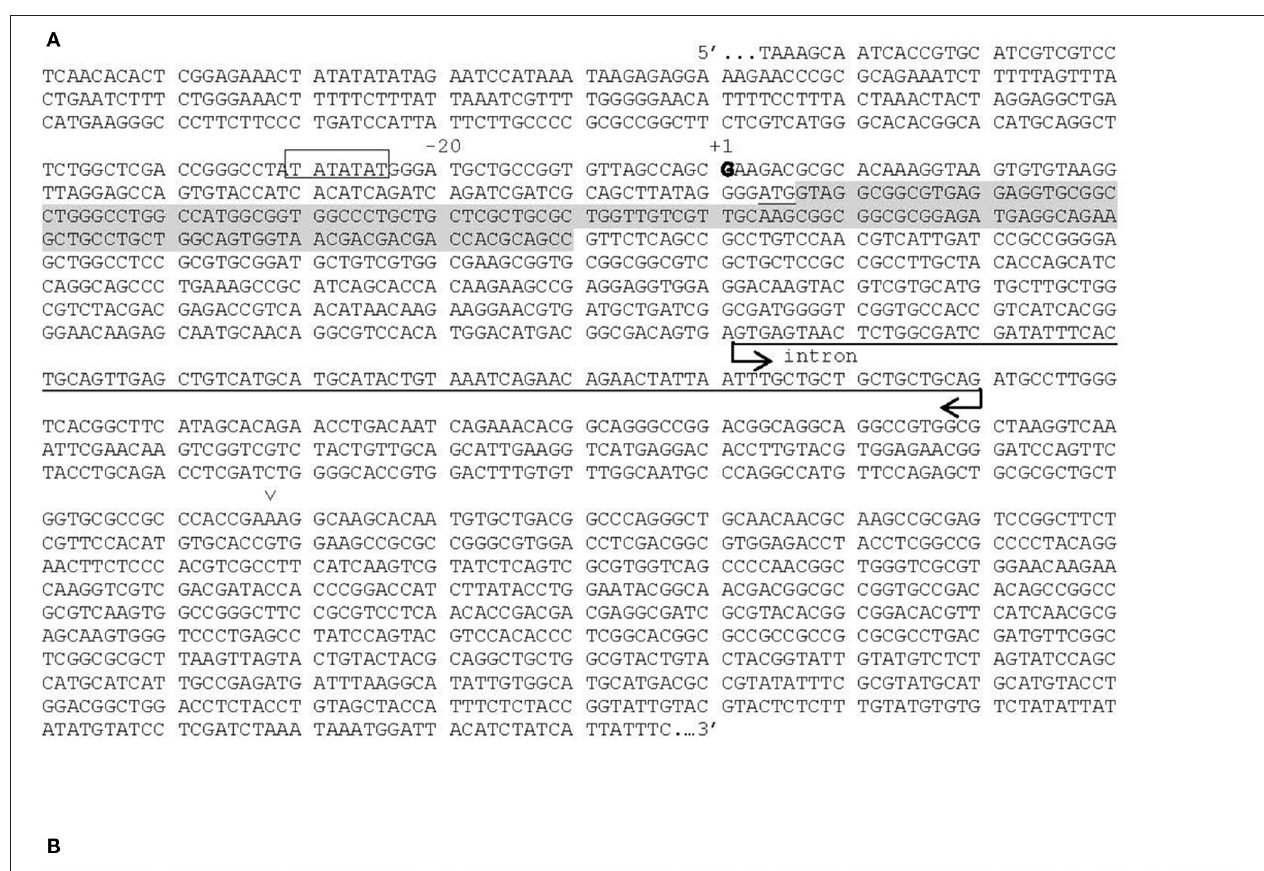
FIGURE 2 | Genomic and predicted protein sequences of ZmPme3 . (A) Genomic sequence of ZmPme3 , with predicted TATA sequence in a box, + 1 base is in bold, ATG start and TGA stop codons are underlined, predicted signal sequence in gray, and intron indicated by arrows. The position of the “GA” insertion in the Gal-m hybrid NC390/NC394 is indicated by arrows. (B) Predicted protein sequence of ZmPme3 with peptides detected my LC-MS underlined and predicted signal peptide